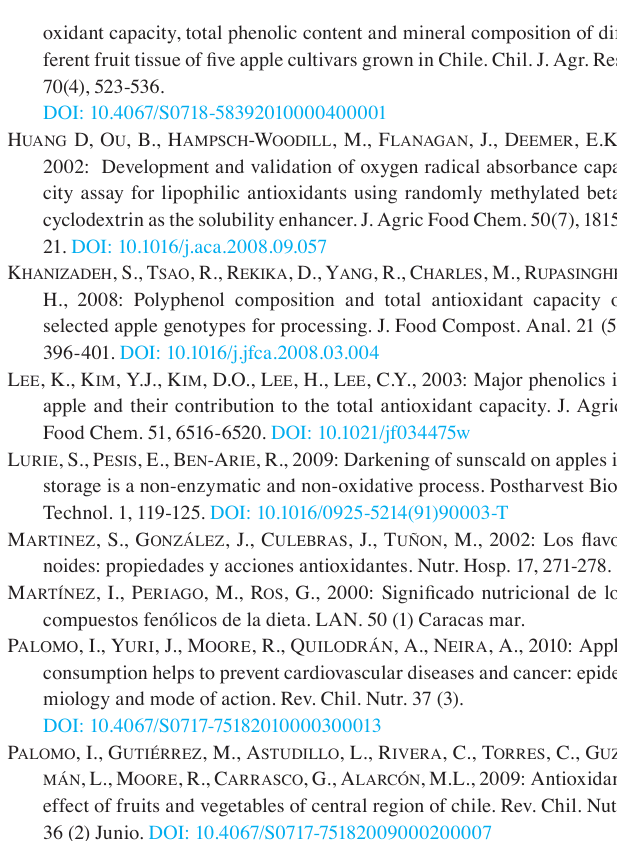
Fig. 9: Quercetin glycosylated between healthy and sun-burned fruit from conventional (A) and organic (B) orchard.